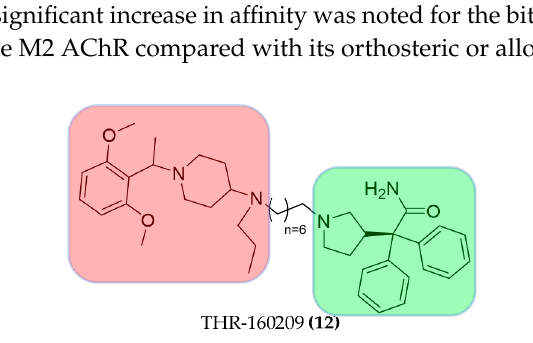
Figure 7. Structures of bitopic hybrids. 12 M2 acetylcholine receptor antagonist. Green: orthosteric building block, red: allosteric building block.